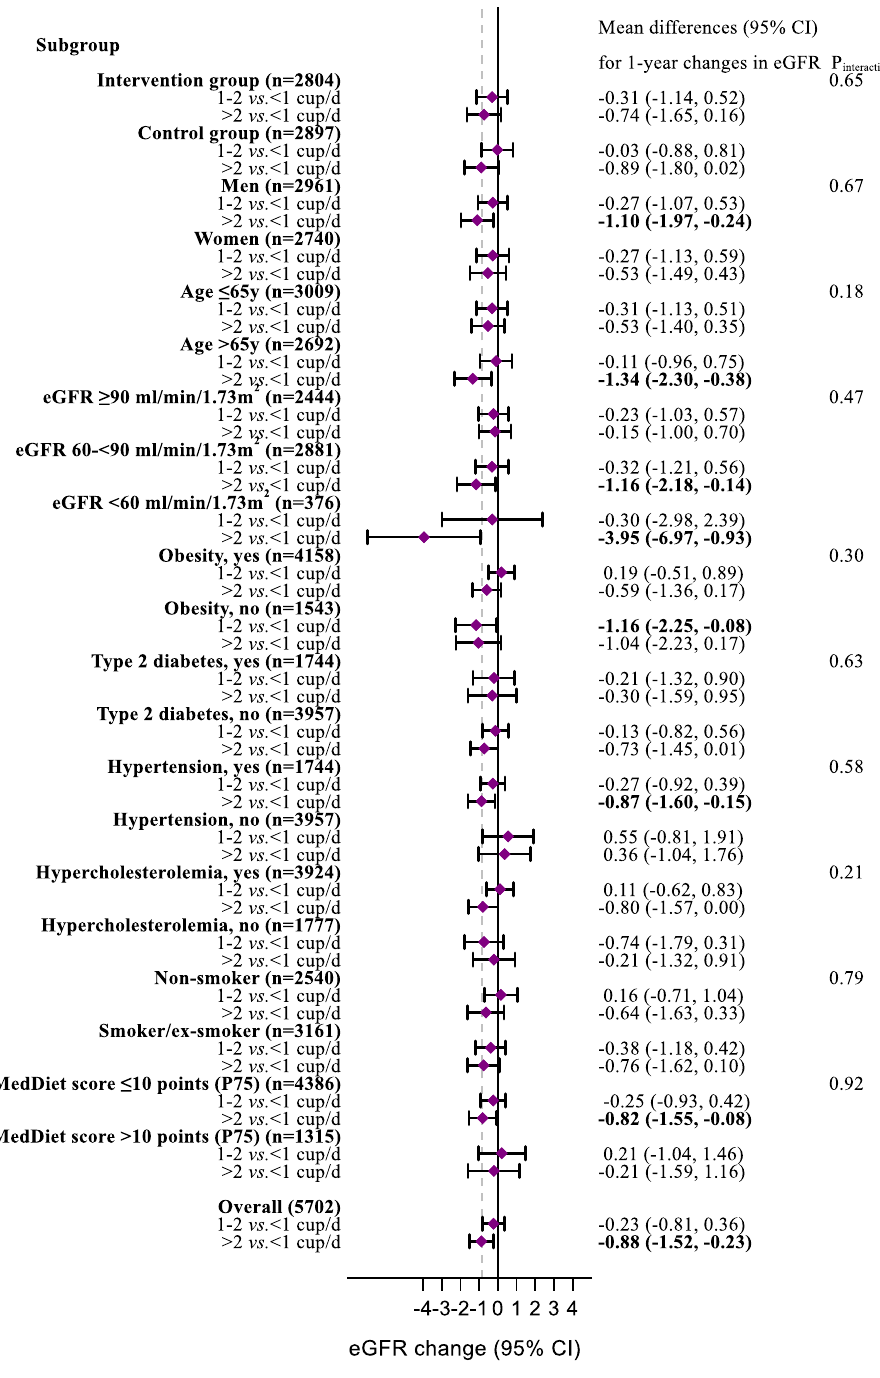
Figure 1. Mean multivariable-adjusted differences (95% CI) for 1-year changes in eGFR between the two highest and the lowest categories of caffeinated coffee consumption at baseline stratified by group. eGFR, estimated glomerular filtration rate; MedDiet, Mediterranean diet. Model adjusted (except the stratification factor itself) for sex (men or women), age (years, continuous), baseline eGFR (mL/min/1.73 m 2 , continuous), BMI (kg/m 2 , continuous), smoking (never, current, or former smoker), educational level (primary, secondary education or academic/graduate), physical activity (MET-min/day, continuous), type 2 diabetes prevalence (yes or no), dyslipidemia (yes or no), hypertension (yes or no), center (four categories by number of recruited participants: < 200, 200–250, 250–300, or ≥ 300), intervention group (intervention or control group), MedDiet score (17-points, continuous), total energy intake (kcal/day, quartiles), dietary intakes of total protein, saturated fat, alcohol, fiber, sodium, magnesium, potassium (each categorized at energy-adjusted quartiles), 1-year changes in systolic blood pressure (mmHg, continuous), and 1-year changes in body weight (kg, continuous), decaffeinated coffee, and tea consumption (cup/day, continuous). All analyses were conducted with robust estimates of the variance to correct for intra- cluster correlation. a P < 0.05 (compared to the reference group). The standard serving size of 1 cup was defined as 50 mL in the questionnaire. (StataCorp. 2015. Stata Statistical Software: Release 15. College Station, TX: StataCorp LP. https:// www. stata.